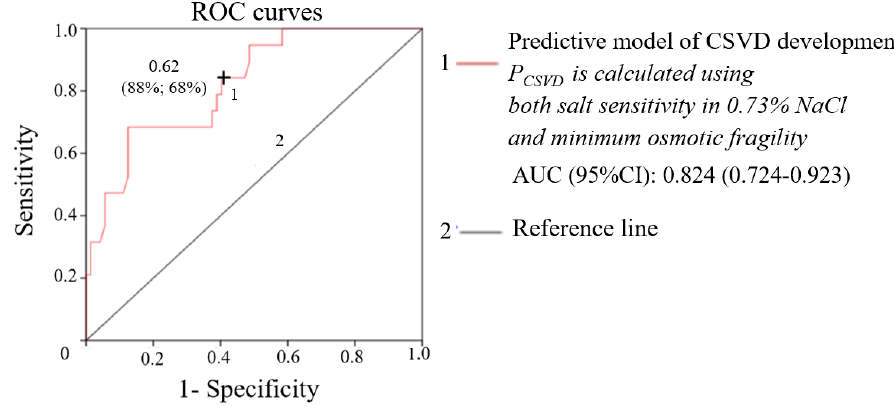
Figure 4. ROC curve of the predictive model of CSVD development.